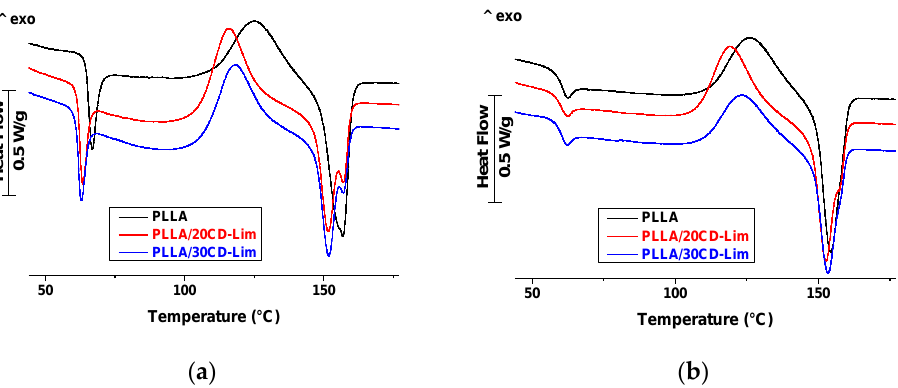
Figure 3. SEM micrographs of PLLA ( a ), PLLA/20CD-Lim ( b ), and PLLA/30CD-Lim ( c ) cryogeni- cally fractured surfaces.